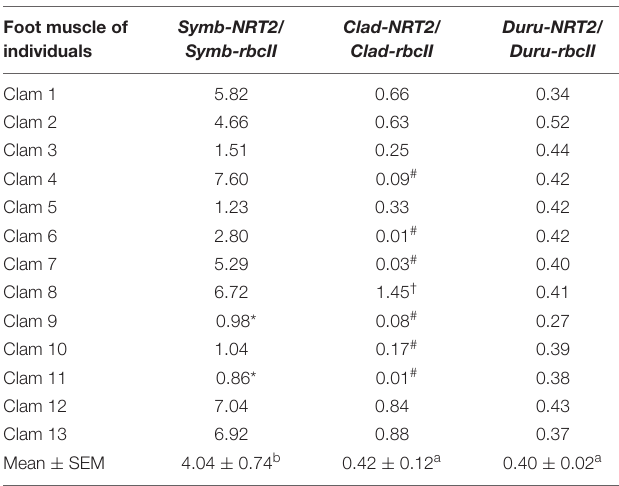
TABLE 6 | Ratios of the transcript levels of nitrate transporter 2 ( NRT2 ) to that of form II ribulose-1,5-bisphosphate carboxylase/oxygenase (rbcII) from Symbiodinium (Symb-NRT2/Symb-rbcII), Cladocopium (Clad-NRT2/Clad-rbcII), and Durusdinium (Duru-NRT2/Duru-rbcII) obtained from the foot muscle of Tridacna squamosa ( n = 13).